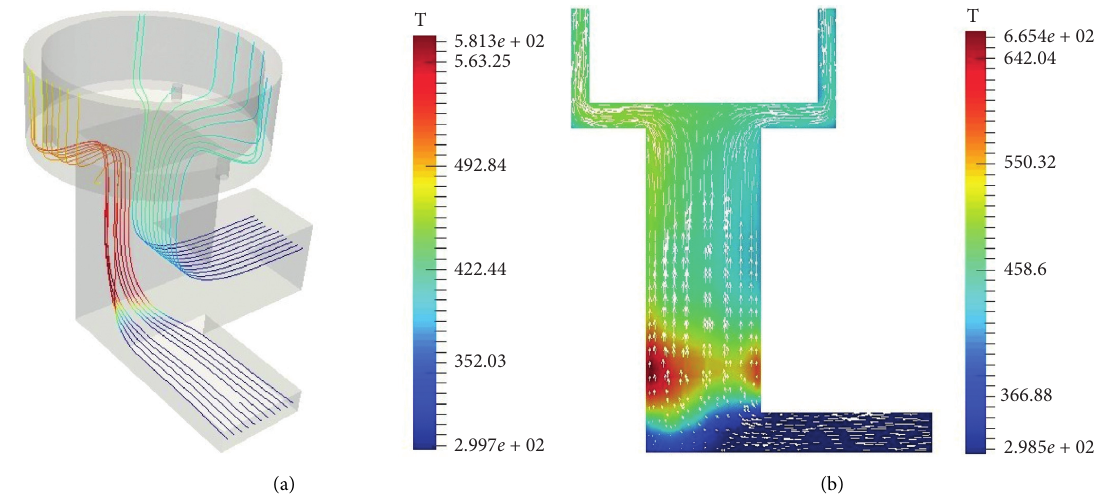
Figure 14: Velocity fields: (a) streamlines of velocity colored by temperature and (b) contour of temperature with velocity